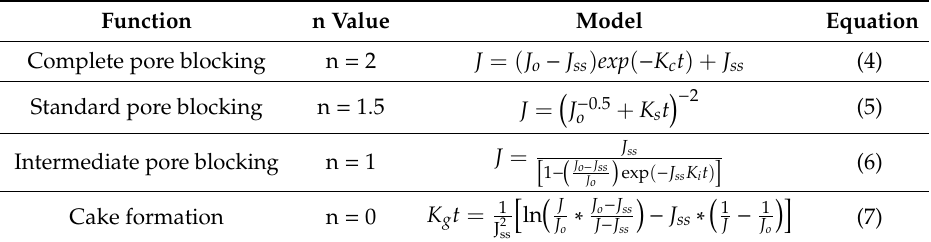
Table 1. Summary of characteristic equations for constant pressure filtration